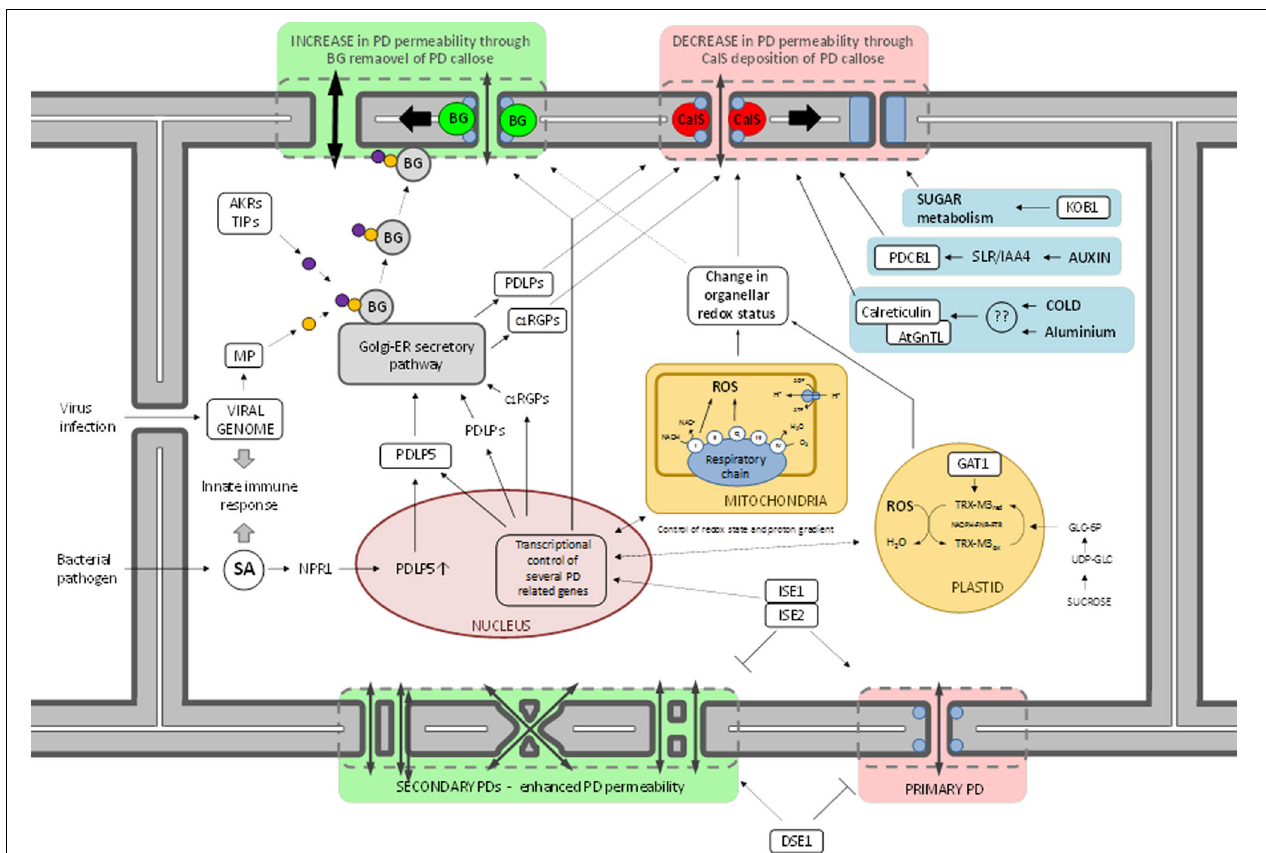
FIGURE 1 | Schematic overview representing molecular factors and signaling components involved in the regulation of PD permeability through CalS- or BG-mediated control of PD callose